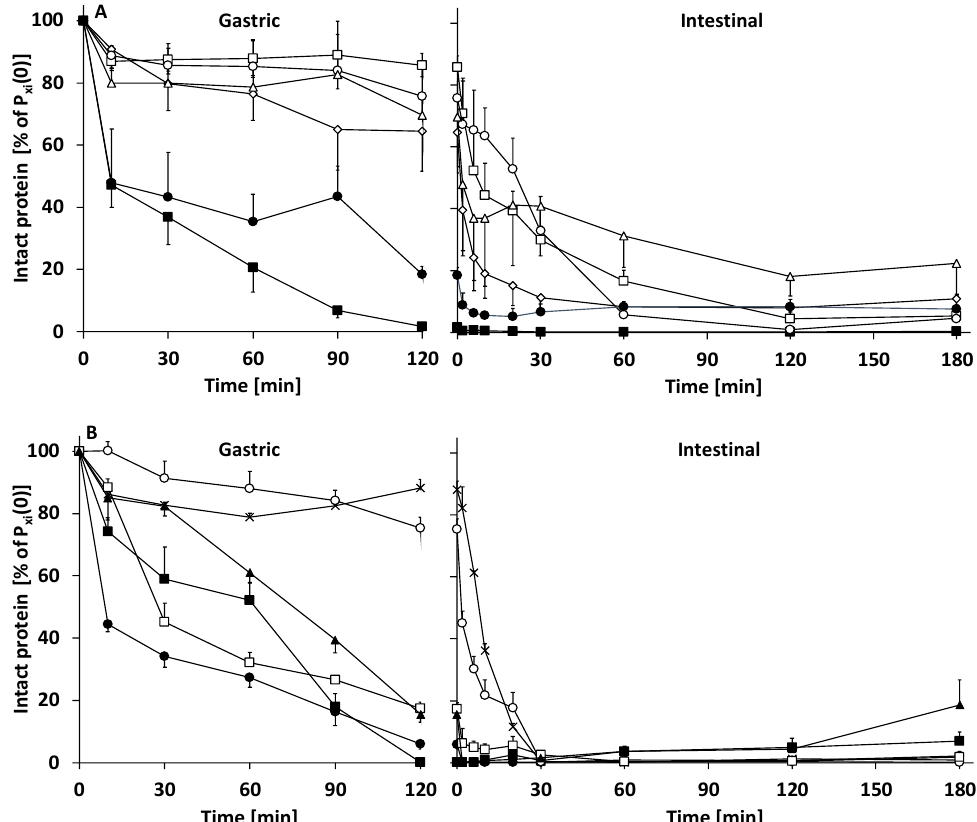
Figure 6. Individual intact protein hydrolysis of the six most abundant proteins in gastric and intestinal digesta in time, as determined by SDS-PAGE and densiometric analysis of bands. ( A ) Human milk (HM), ( B ) infant formula (IF); ( ) lactoferrin, ( ) serum albumin, ( ) α -lactalbumin, ( (cid:52) ) secretory component (of immunoglobulins), ( × ) β -lactoglobulin, ( (cid:78) ) α -casein, ( (cid:4) ) β -casein, and ( • ) κ -casein. Intact protein expressed as % of respective intact milk protein amount at t = 0 (P xi (0)). Mean + or − SEM (n = 3).